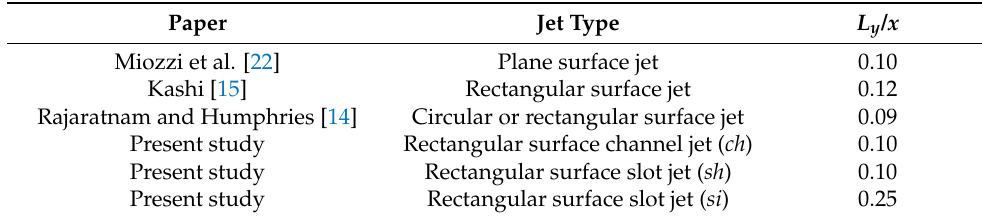
Figure 11. Downstream evolution of normalized half width L y / b 0 at z = 0.5 h 0 from ( a ) simulation with RANS and ( b ) simulation with DES. Table 2. Lateral growth rates in literature.